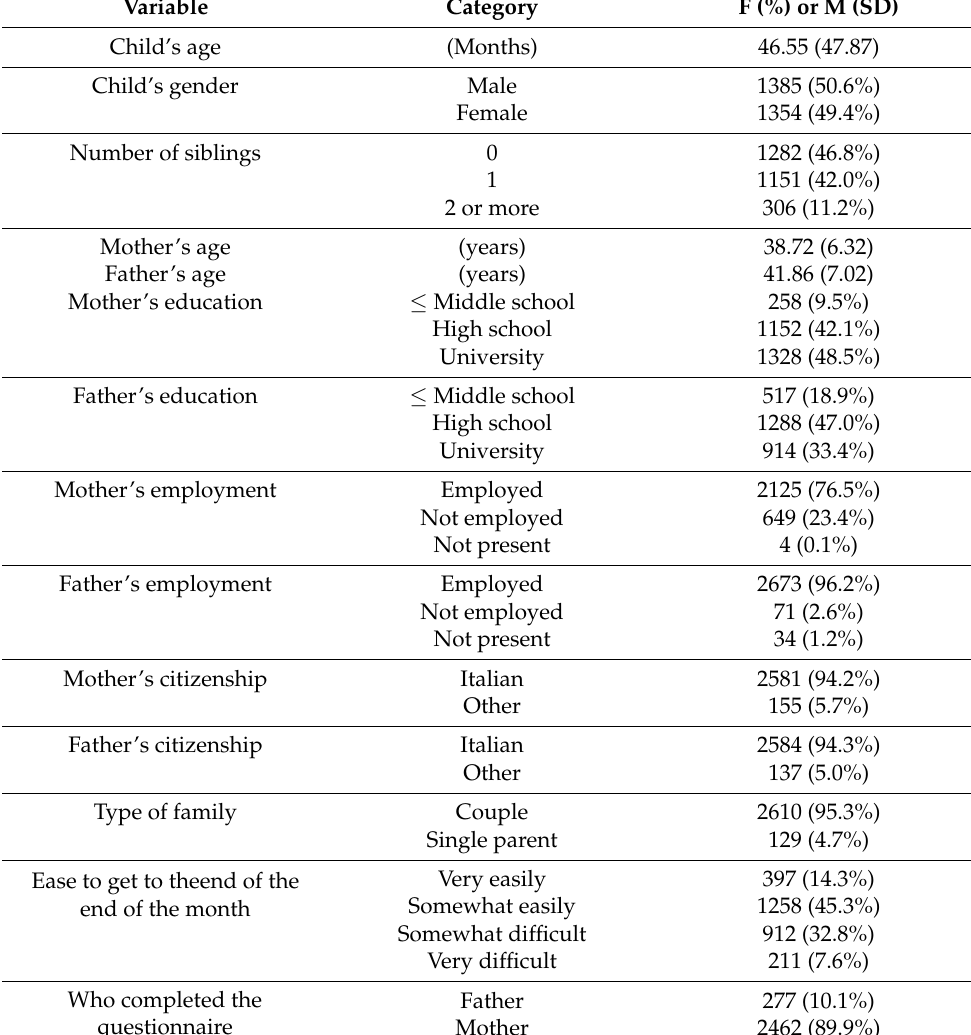
Table 1. Participants’ characteristics (Study